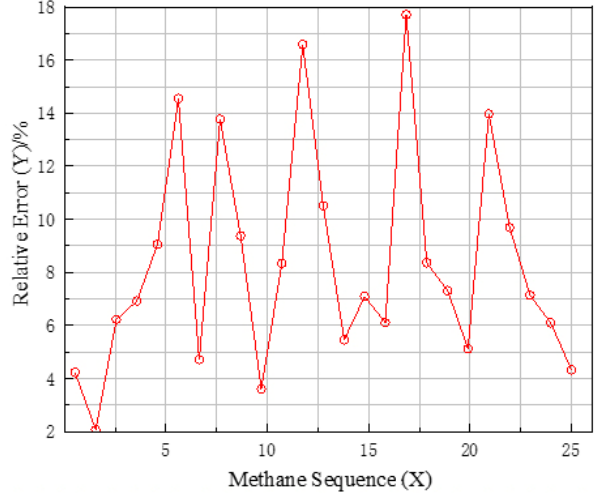
Figure 8. Grey RBF neural network model relative error.